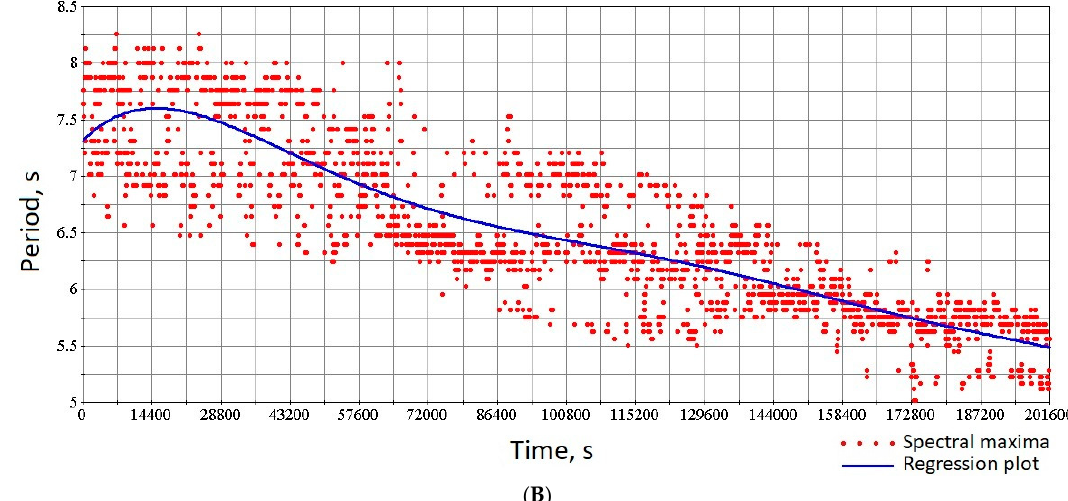
Figure 3. ( A ) Swell wave spectrogram recorded by a laser meter of hydrosphere pressure variations in the period from 17 August to 19 August 2010 and ( B ) regression plot, constructed on the spectral maxima singled out from the signal spectrogram recorded in the period from 17 August to 19 August 2010.